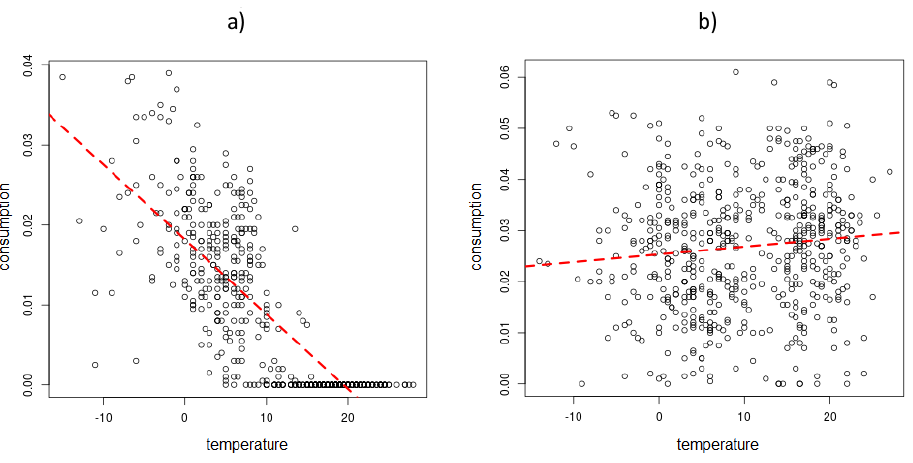
Figure 6. Consumption values (fraction of the tank’s capacity) dependent on the outside temperature ( ◦ C) for the exemplary temperature-dependent ( a ) and temperature-independent ( b )